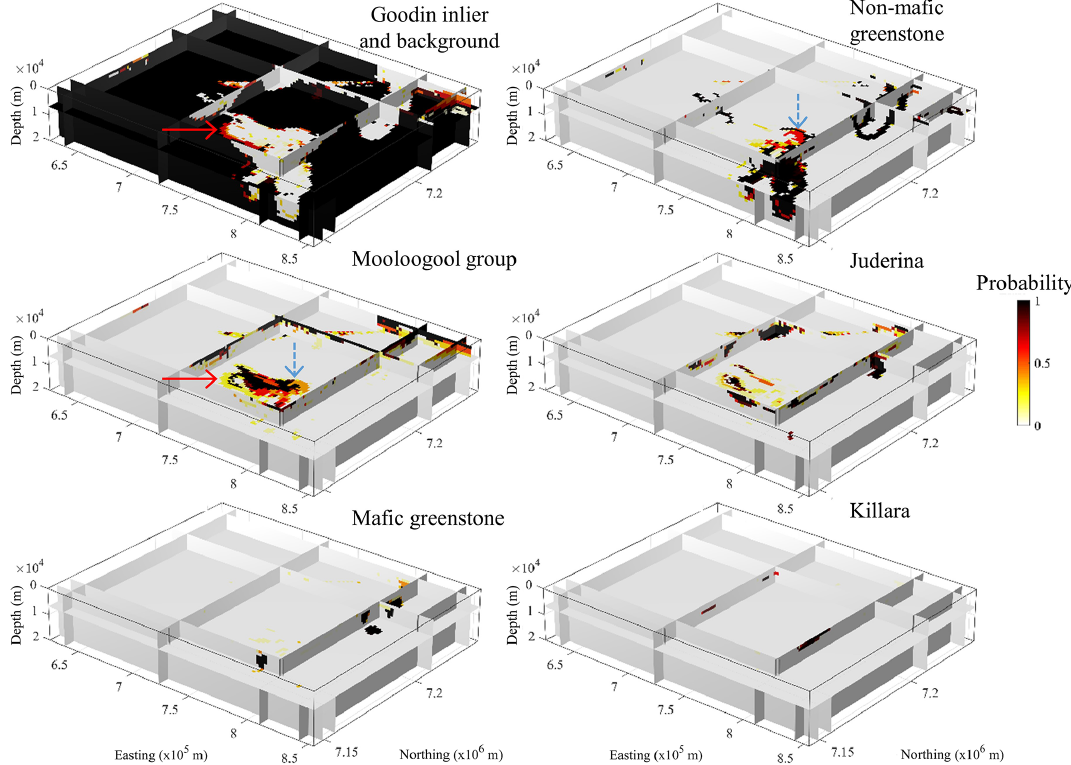
Figure 10. Frequentist probability volumes of recovered lithologies calculated as per Eq. (3). The arrows are drawn to support